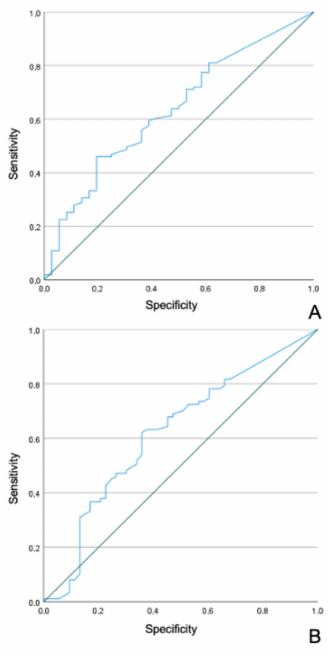
Figure 1. ROC cures for LN ratio and OS ( A ) and DFS ( B